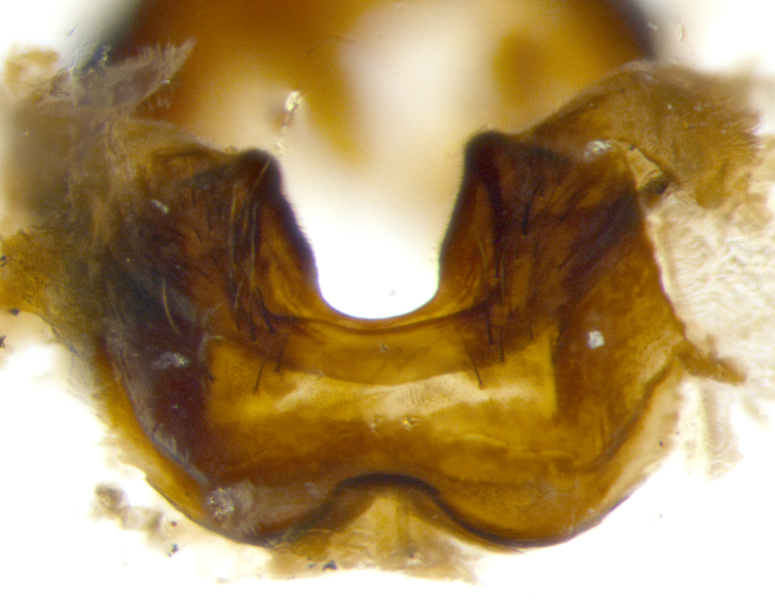
sternite 5, ventral view